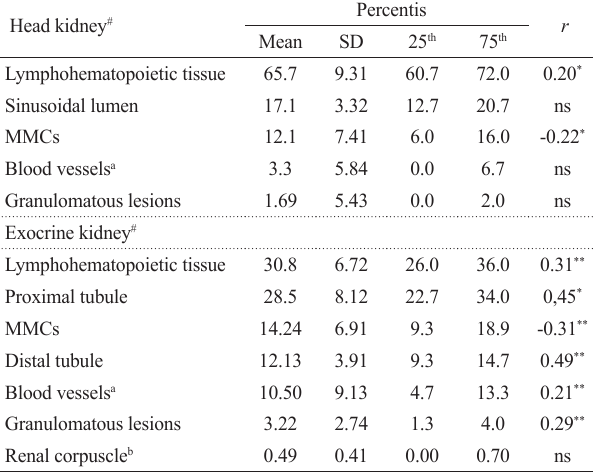
Tab. 2 . Descriptive statistic values for structural volumetric